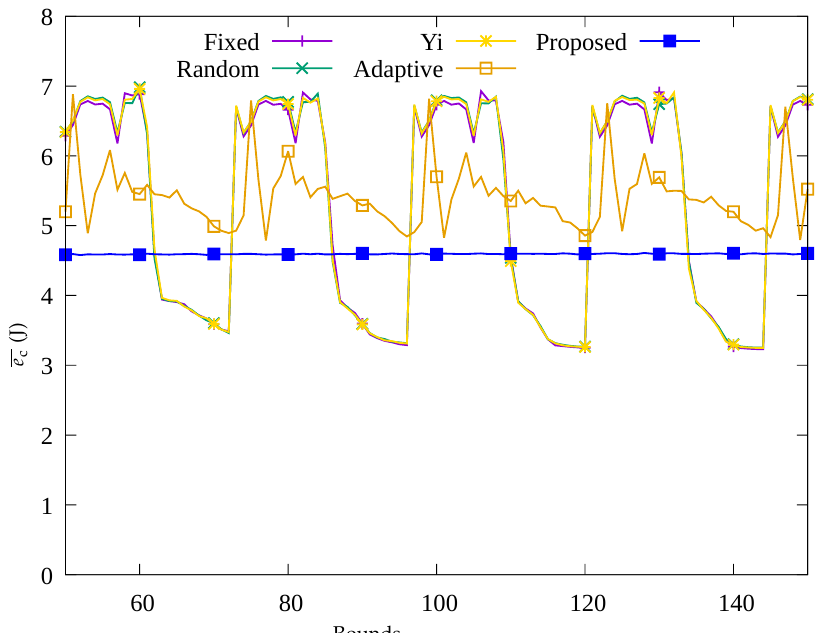
Figure 5. Change in the average amount of consumed energy over time.